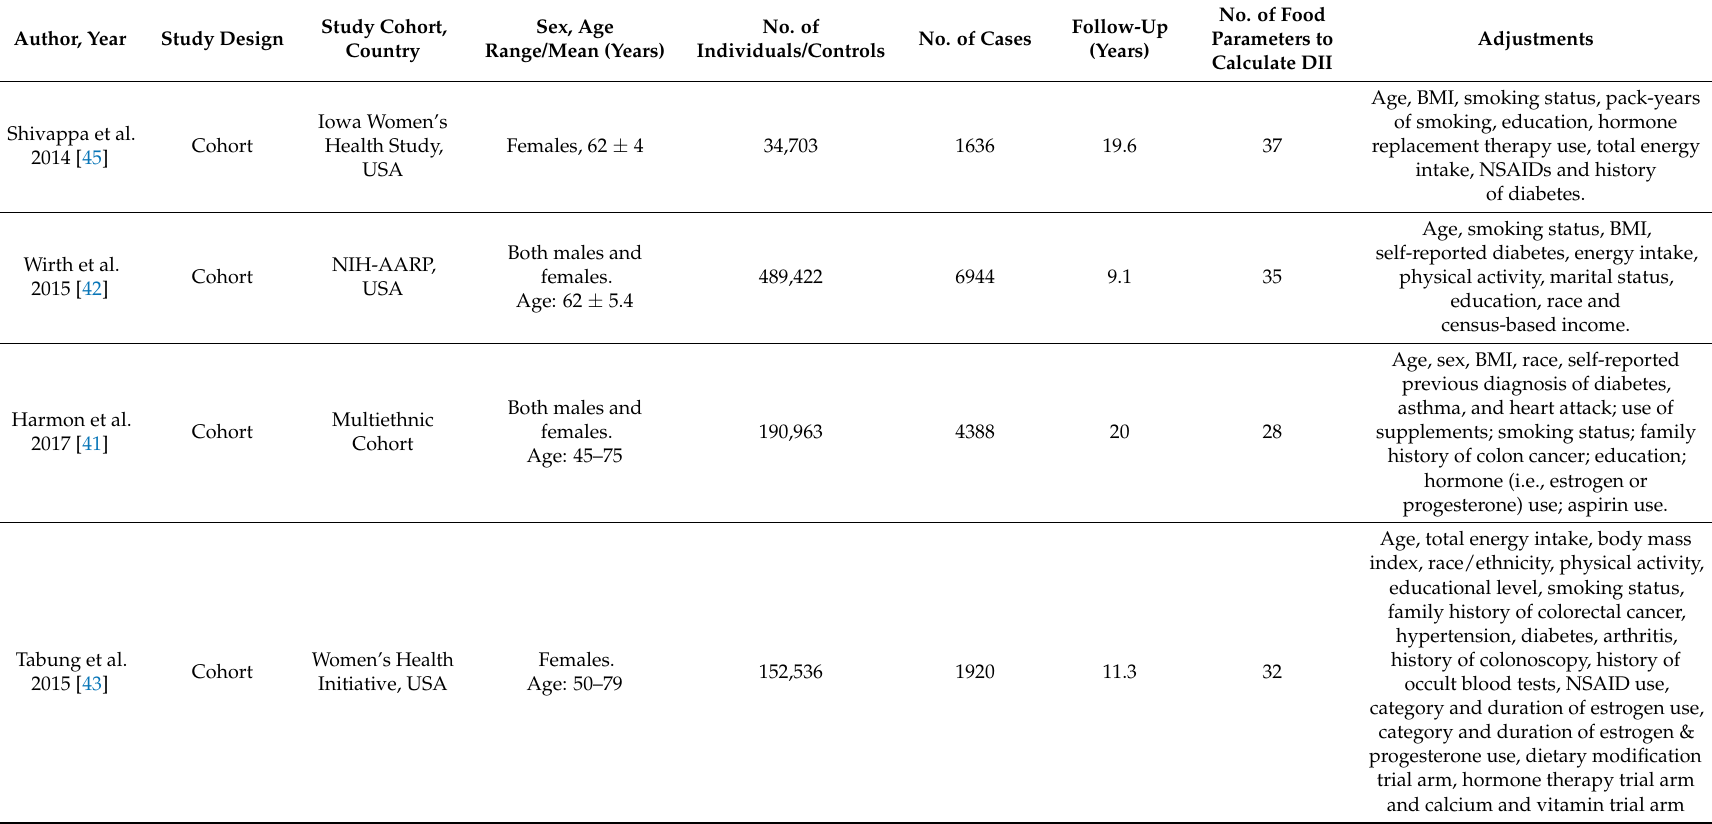
Table 1. Characteristics of studies included in the